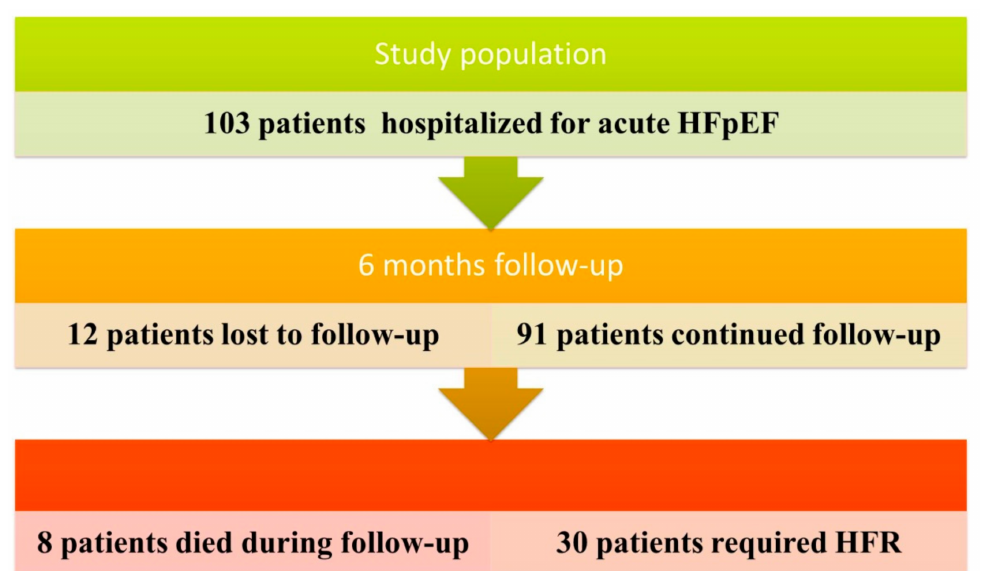
Figure 1. Patient flow-chart at six months. HFR: heart failure readmission, HFpEF: Heart failure with preserved ejection fraction.